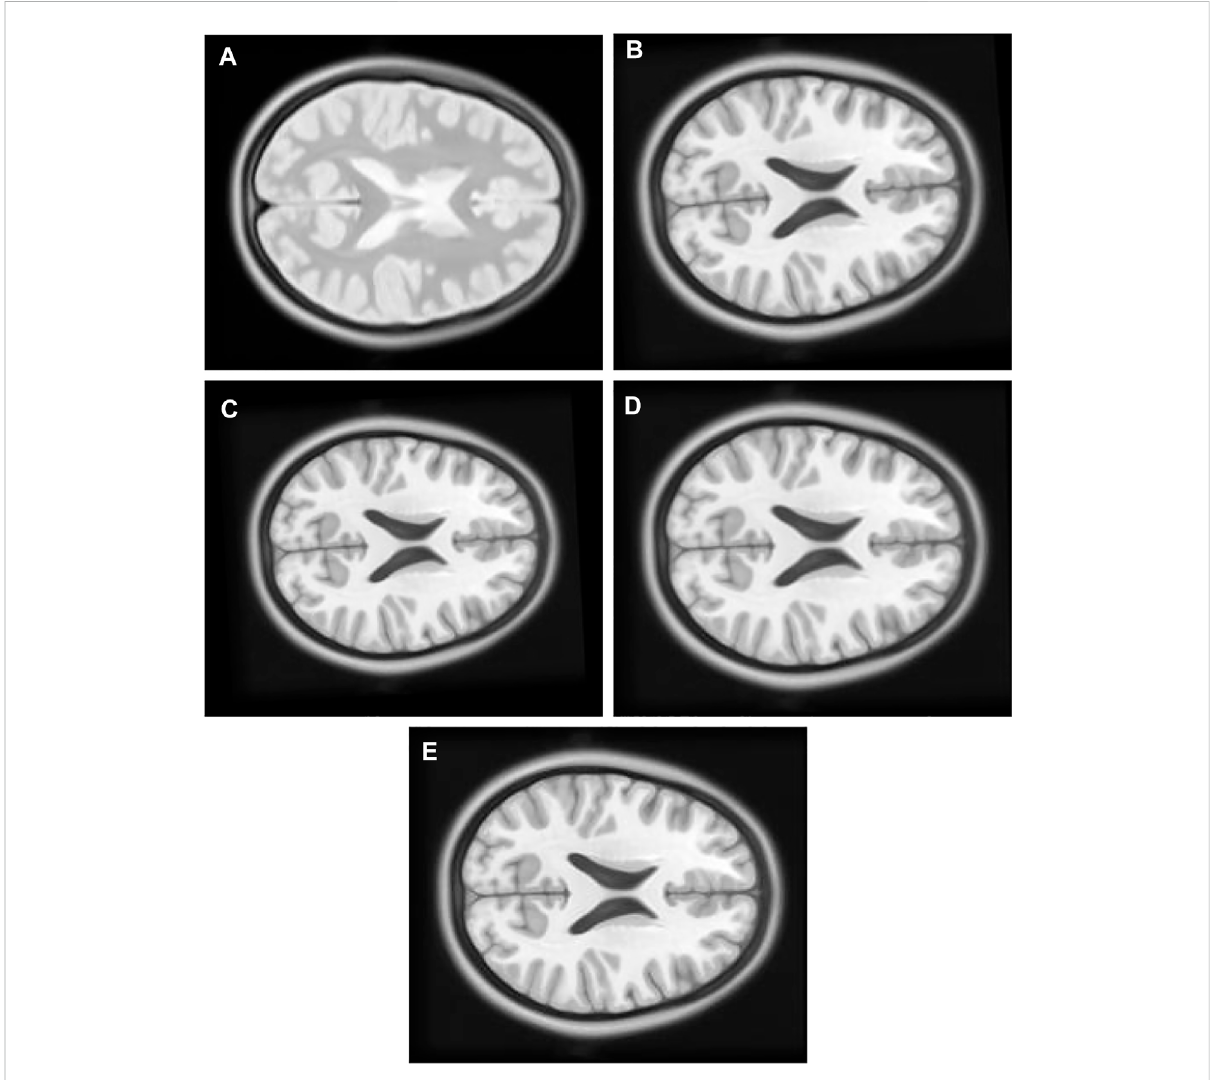
FIGURE 9 (A) Multi Modal Experiment 1 Float: row fi rst left. (B) Multi Modal Experiment 1 GA output: row fi rst right. (C) Multi Modal Experiment 1 PSO output: row second left. (D) Multi Modal Experiment 1 PSO and Powell Output: row second right. (E) Multi Modal Experiment 1 TPSysIR Output: row third